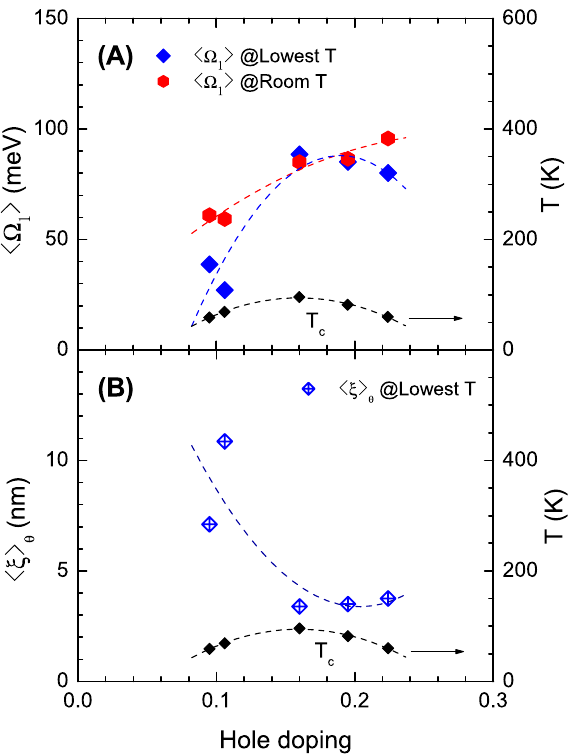
2 B (ω) Figure 4. Average frequencies of I and the coherence lengths for cuprates at various doping levels. ( A ) The doping-dependent average frequencies at two (lowest and room) temperatures. ( B ) The doping-dependent coherence lengths at the lowest temperature in the superconducting